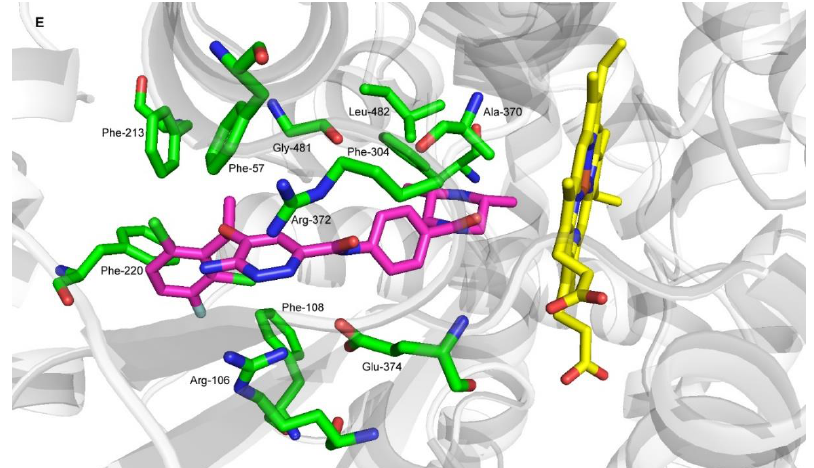
Figure 5. Flexible molecular docking of ensartinib into ABCB1, ABCG2, and CYP3A4 structures and analysis of ensartinib’s interactions with ABCB1 ATPase domain using ATPase assay. ( A ) Molecular docking of ensartinib into the inward-facing form of ABCB1. The top-ranked poses of ensartinib (−12.6, −9.5, and −9.3 kcal/mol) are shown for M-, H-, and R-sites, respectively. Ensartinib is shown in magenta, and protein residues within 4 Å of the ligand are shown as green sticks and labeled. ( B ) Flexible molecular docking of ensartinib into nucleotide binding domains (NBDs) of the outward-facing form of ABCB1. Ensartinib is shown in magenta, and the ATP molecule that originally co-crystallized with the protein backbone is shown using orange sticks. Residues within 4 Å are green, predicted H-bonds are depicted as yellow dashed lines. ( C ) Effects of ensartinib on the vanadate-sensitive ATPase activity of ABCB1-Sf9 membrane fraction. Lower dotted line represents baseline vanadate-sensitive ATPase activity, while upper dotted line shows activated ATPase activity triggered by a reference substrate verapamil. In the inhibition and activation experiments, reductions in the stimulated ATPase activity (indicating inhibitory interaction of the drug toward ABCB1’s ATPase) and increases in baseline ATPase activity (indicating substrate properties of the drug) were recorded, respectively. Statistical analysis of differences between stimulated control and ensartinib-treated samples in inhibition assays (* p < 0.05; ** p < 0.01) as well as analysis of differences between baseline control and ensartinib-treated samples in activation experiments († p < 0.05; †† p < 0.01) were determined using two-tailed unpaired t test. Data are expressed as means ± SDs from three independent experiments. ( D ) Two possible orientations of ensartinib in ABCG2 identified by flexible docking analysis (-12.9 and -12.5 kcal/mol). ABCG2 protein residues predicted to be within 4 Å of ensartinib are show as green sticks. ( E ) Binding of ensartinib to the CYP3A4 structure. Ensartinib is shown in magenta, heme in yellow, and protein residues surrounding the ligand are depicted as green sticks.